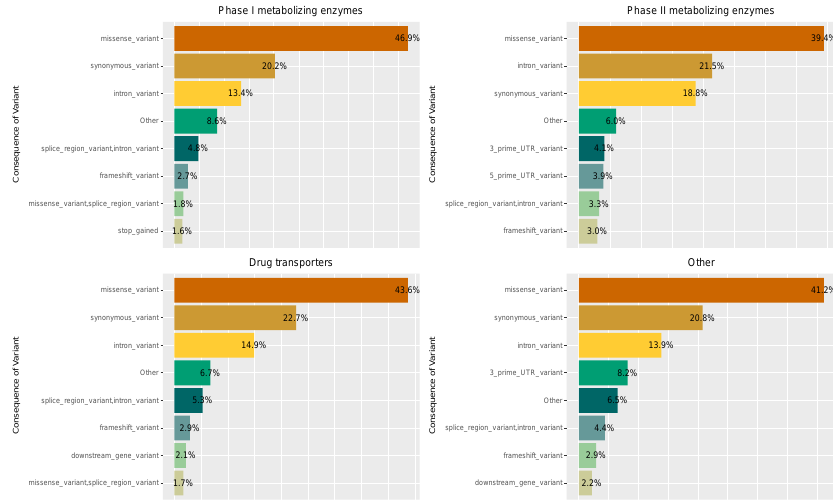
Figure 1. Percentage of the distribution of the VEP variant consequences of the identified pharmacogenomics (PGx) variants in 50,726 DiscovEHR exomes. 231 DMET genes were grouped in 4 categories: Phase I metabolizing enzymes, Phase II metabolizing enzymes, Transporters and Others. Abbreviations: DMET, Drug Metabolizing Enzymes and Transporters; VEP, Variant Effect Predictor.